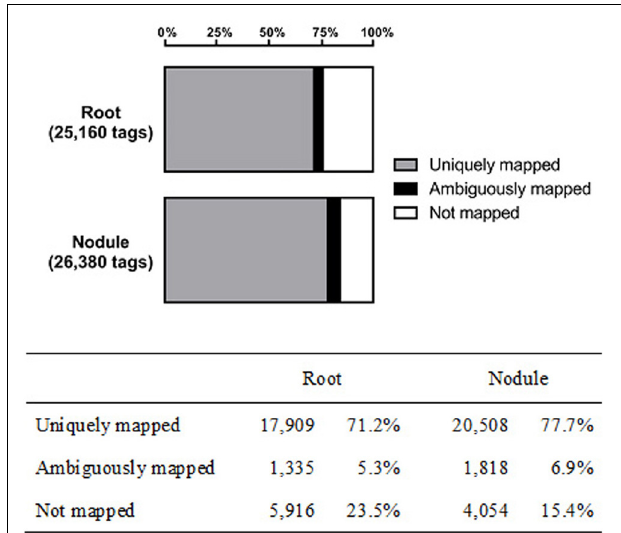
FIGURE 2 | Tissue-specific gene expression in chickpea cultivar Beja 1. Outer numbers represent genes that are expressed in root (left) or nodule (right) tissue, while the number within the overlap represents commonly expressed genes.